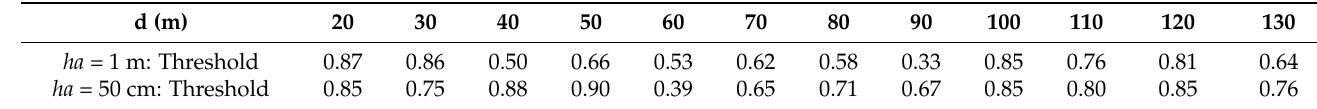
Table 3. Thresholds used in step 5 of Algorithm